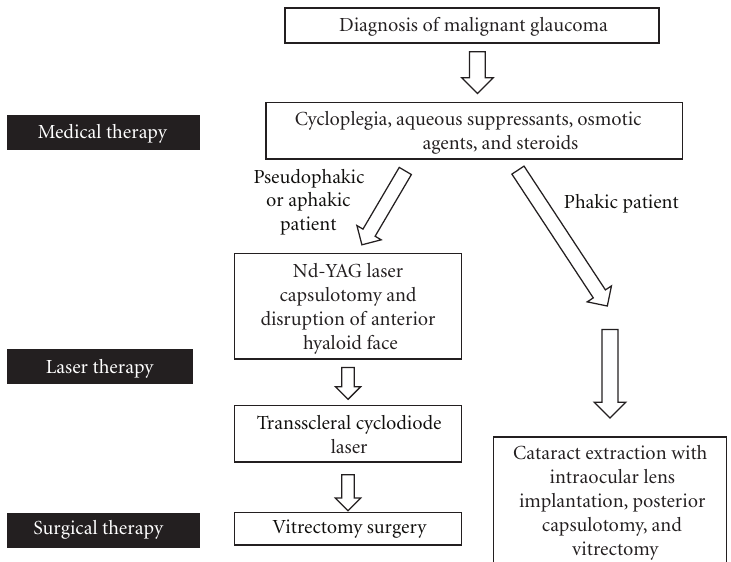
Figure 1: Management pathway for malignant